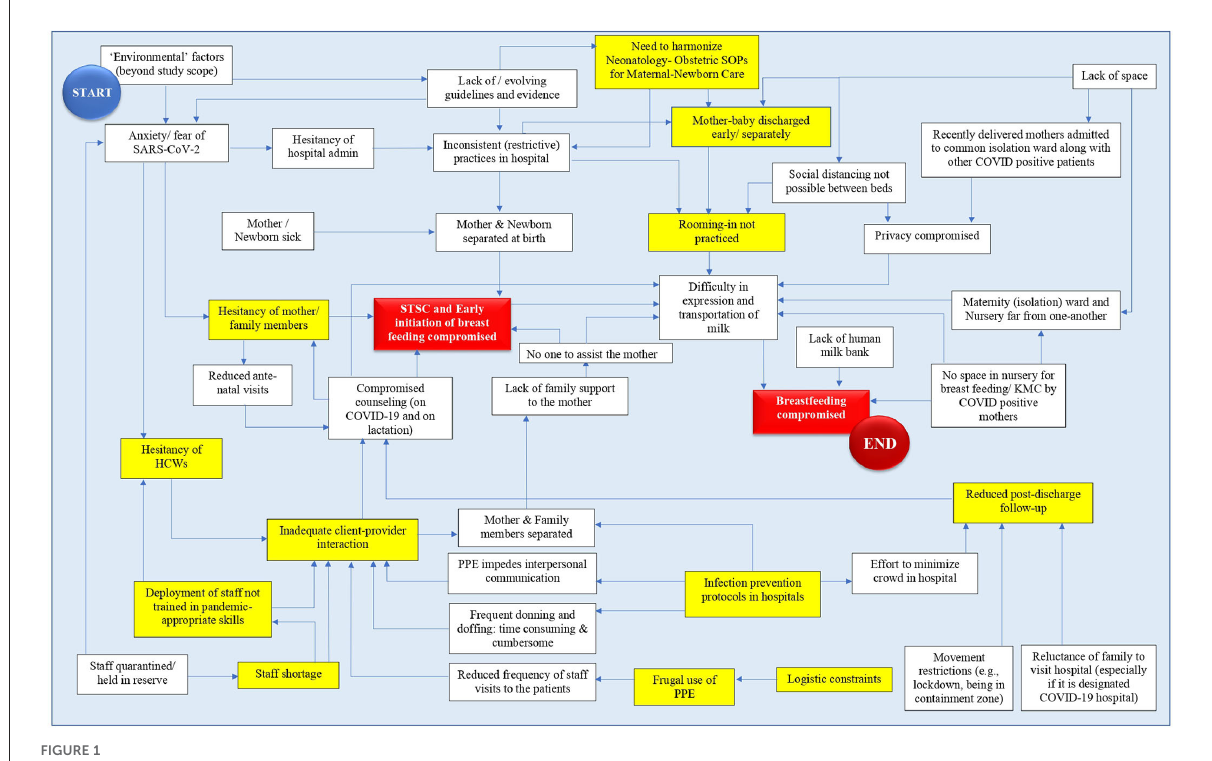
FIGURE1 Analytic framework depicting the pathways of impaction of optimal breastfeeding practices in institutionalized mother-newborn dyads during the COVID-19 pandemic. The various barriers are depicted in the white boxes – the ones targeted by the study institution for mitigation have been highlighted in yellow. Boxes highlighted in red represent end-points; HCW, Health Care Worker; KMC, Kangaroo Mother Care; PPE, Personal Protection Equipment; STSC, Skin-To-Skin Contact; SARS-CoV-2, severe acute respiratory syndrome coronavirus 2; COVID, Coronavirus disease; SOP, Standard Operating Procedure